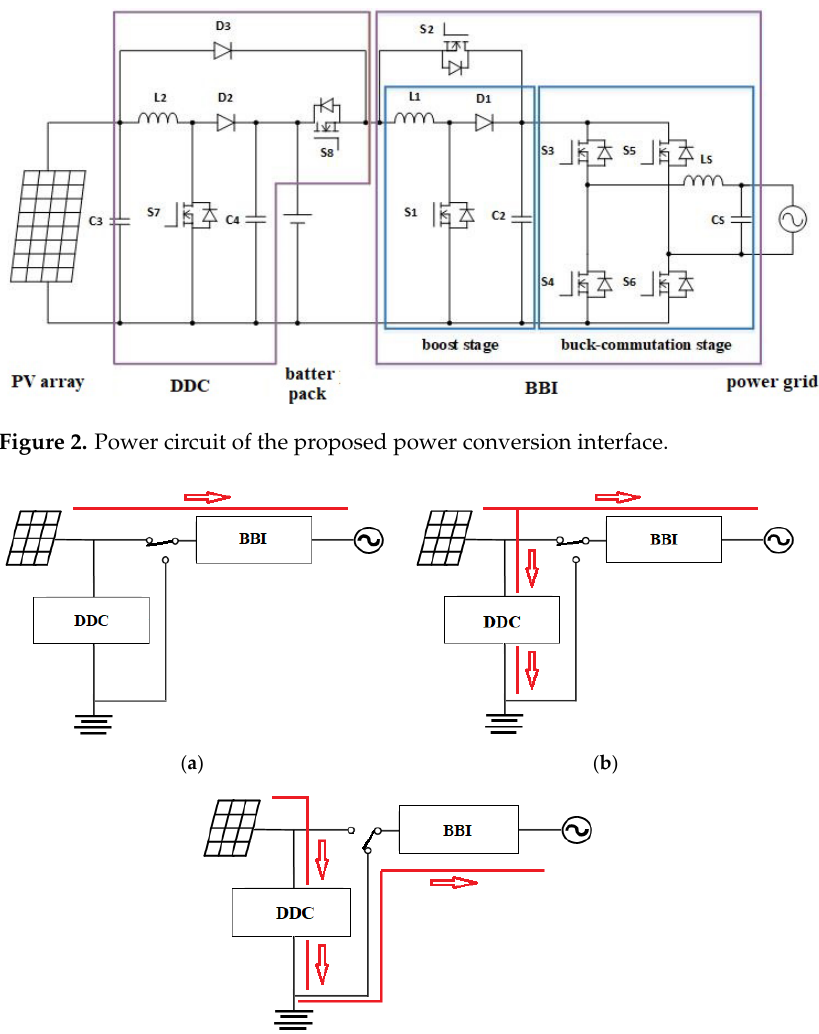
Figure 3. Operation of the proposed power conversion interface, ( a ) mode I, ( b ) mode II, ( c ) mode